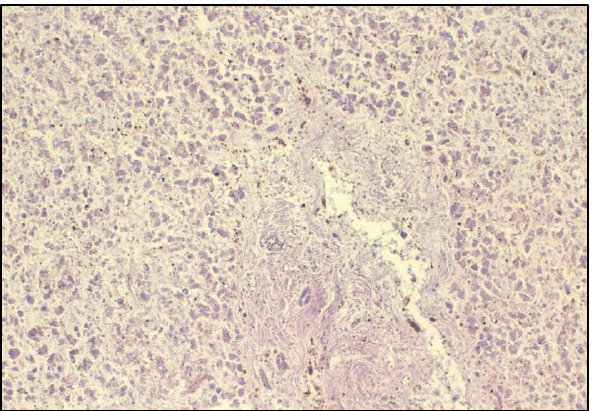
Figure 2. Histological examination of hepatic tissue. Magnification 40×. Hematoxylin and eosin